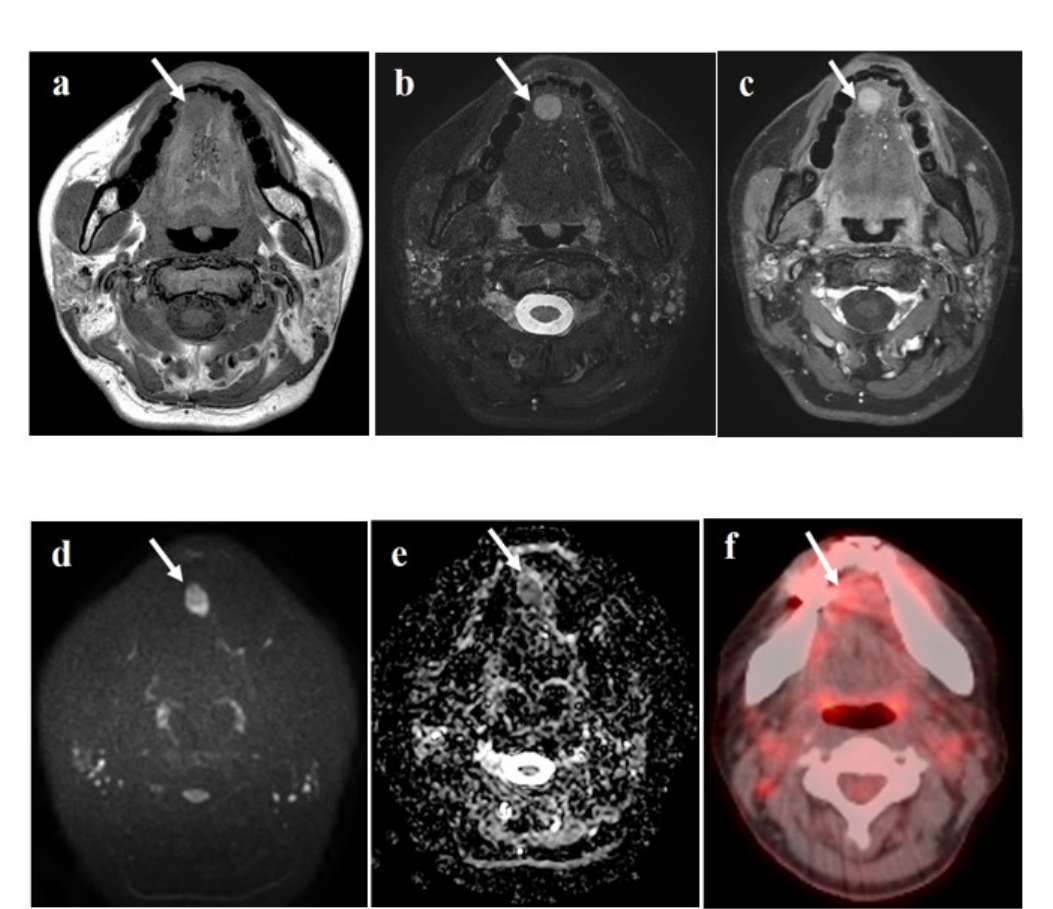
Figure 3. On T1-weighted image ( a ), the nodule is isointense with partially defined. On T2-weighted image ( b ), the nodule reveals omogeneously high signal intensity. The lesion shows a homogeneous enhancement on the contrast-enhanced T1-weighted image ( c ). The nodule showed diffusion restriction on diffusion-weighted image and ADC map ( d,e ). On 18-F FDG PET/CT image ( f ), the nodule shows mild FDG uptake with SUVmax of 4.8 g/mL.